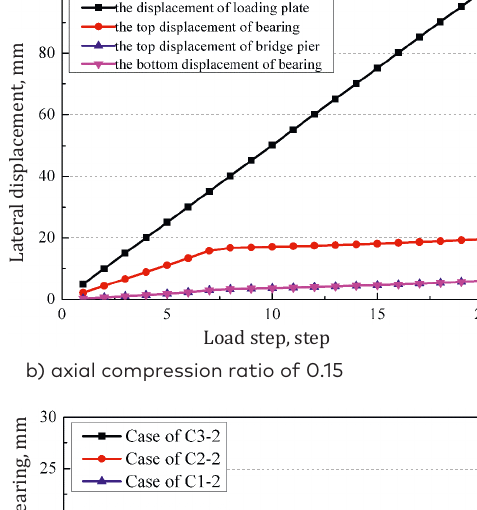
a) axial compression ratio of